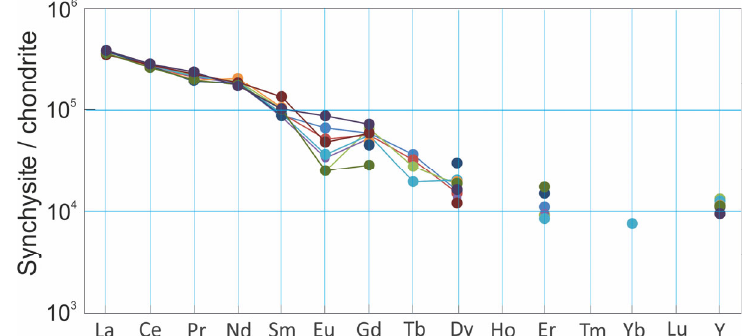
Figure 10. C3-chondrite-normalized REE distribution in synchysite of the quartz–carbonate–sulfide Figure 10. C3 ‐ chondrite ‐ normalized REE distribution in synchysite of the quartz–carbonate–sulfide vein from the Rožn á uranium vein from the Rožná uranium deposit.